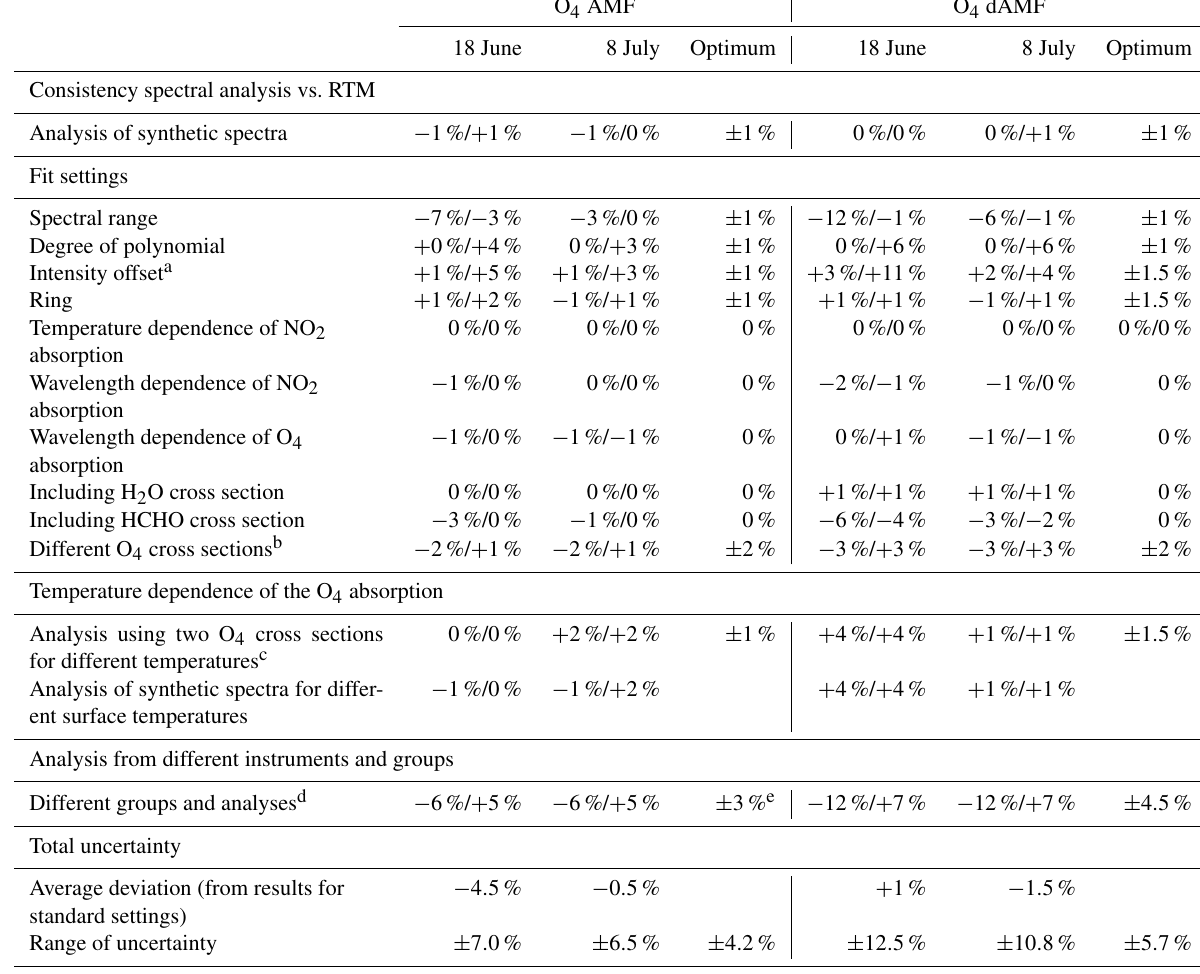
Table 10. Summary of uncertainties of the measured O 4 (d)AMFs for the middle period of each selected day. The two numbers left and right of the slash indicate the minimum and maximum deviations. The columns labelled “optimum” indicate the uncertainties which could be reached if optimum instrumental performance was ensured and optimum cross section was available. O 4